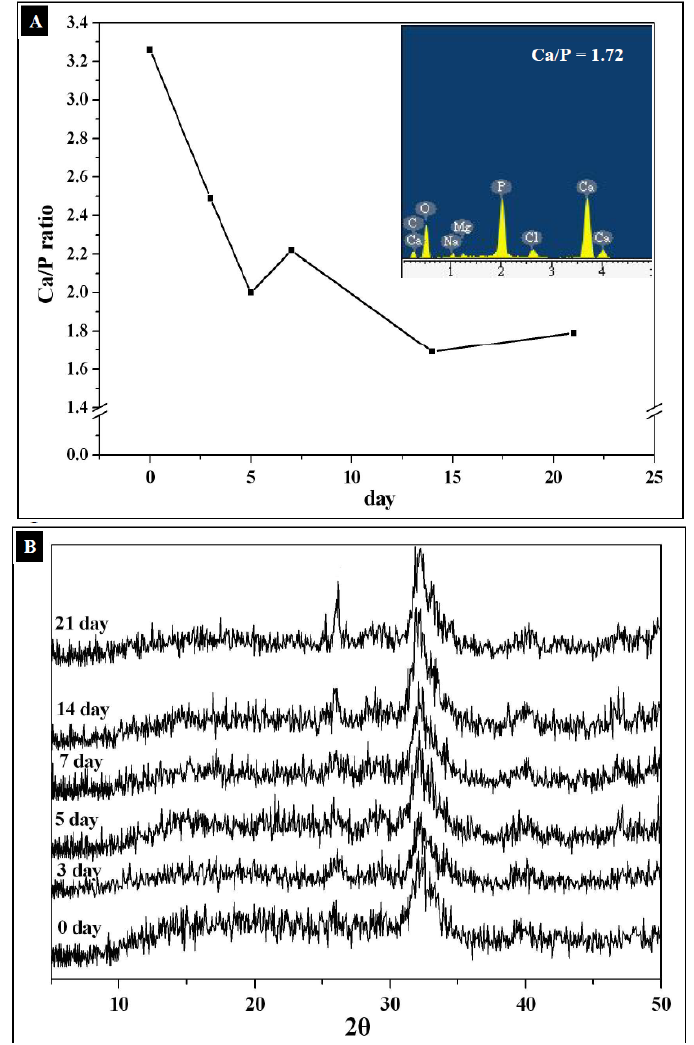
Figure 5. ( A ) Ca/P ratios of the mineralized TPP-CG composites determined by EDX spectra ( B ) X-ray diffraction patterns of mineral grown in TPP-CG